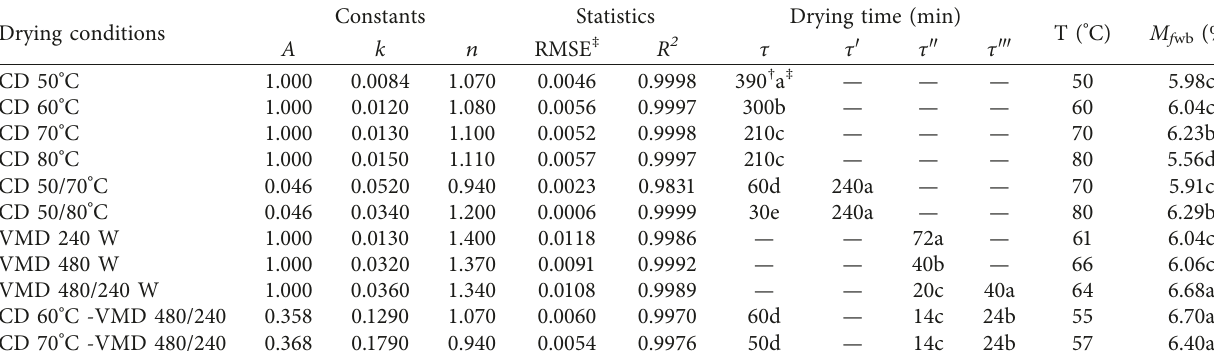
Figure 1: (a). Drying kinetics of Boletus edulis samples processed using convective drying (CD) at temperatures of 50, 60, 70, and 80 ° C, as well as convective finish drying at 70 and 80 ° C preceded by convective predrying at 50 ° C. (b) Drying kinetics of Boletus edulis samples processed using vacuum microwave drying (VMD) at powers of 240 and 480 W as well as vacuum microwave predrying at 480 W and finishing drying at 240 W. (c) Drying kinetics of Boletus edulis samples processed using vacuum microwave finish-drying (VMFD) at 480/240 W after convective predrying (CPD) at temperatures 60 and 70 ° C. Table 1: Final moisture content (Mfwb), maximum temperature of the sample T , convective drying time ( τ , τ′ , time for CD steps 1 and 2, resp.), vacuum microwave drying time ( τ″ , τ ‴ for VMD steps 1 and 2, resp.), and constants A, k , and n of the modified Page model describing the drying kinetics of cepe mushrooms as affected by the drying